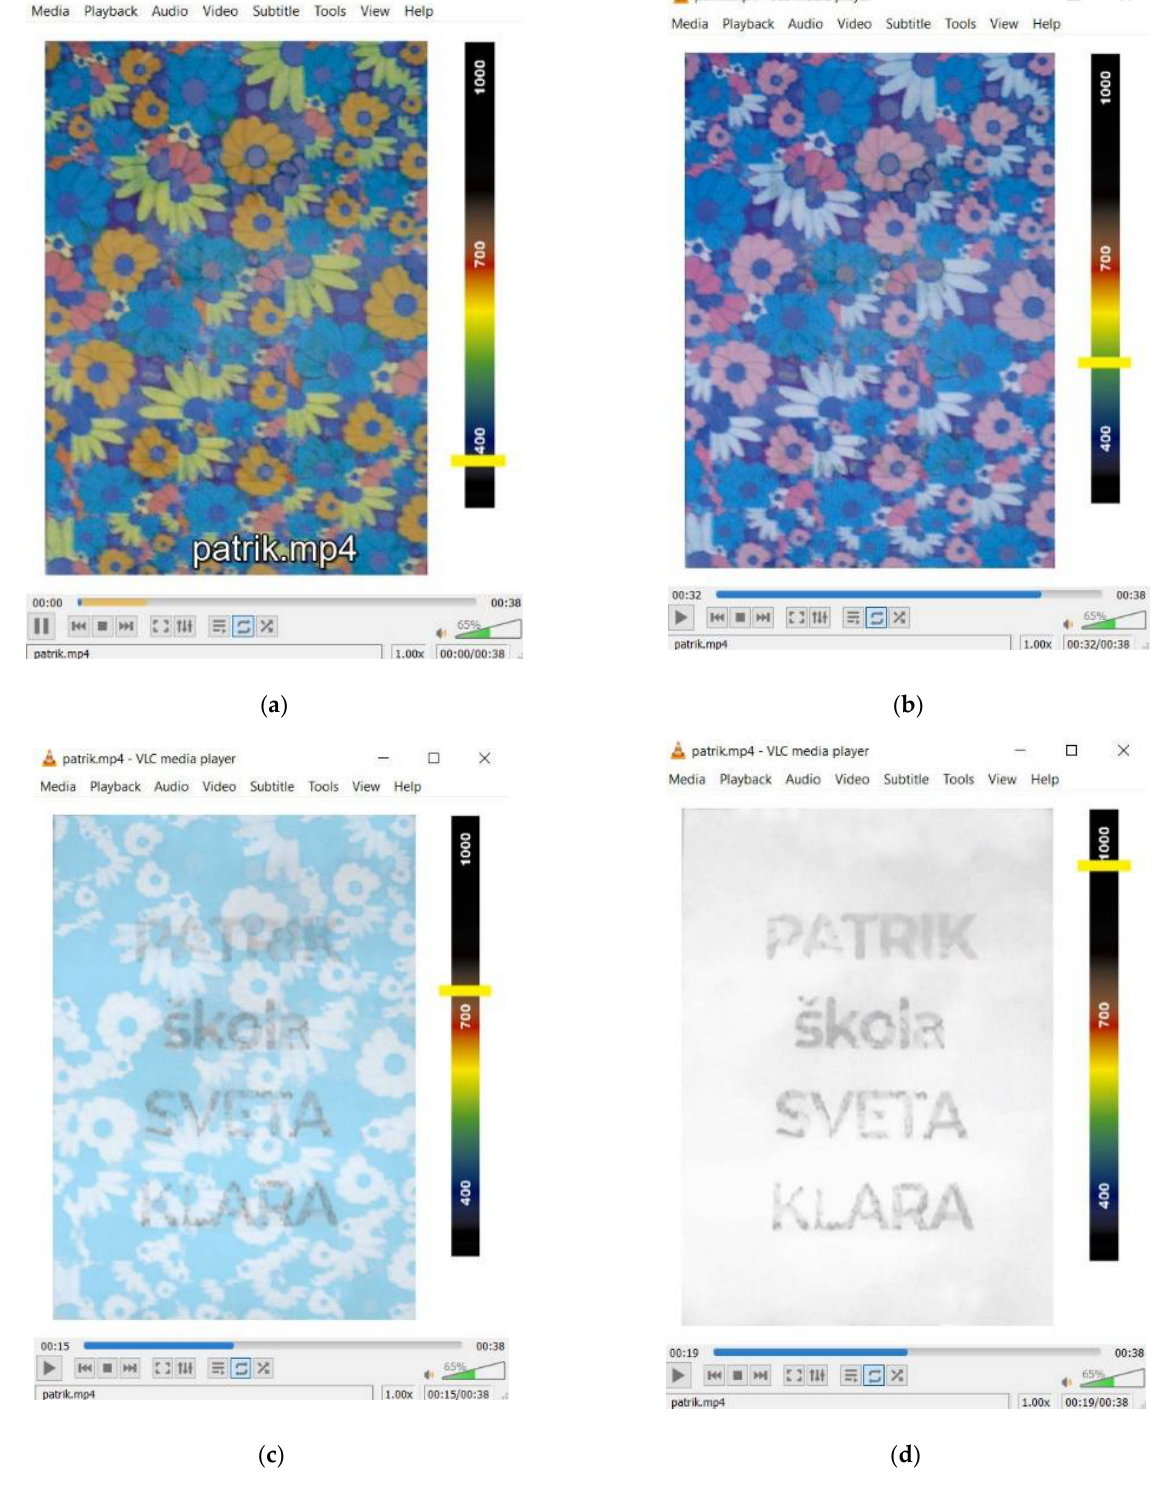
Figure 4. ( a ) Animation stop on 400 nm; ( b ) animation stop on 530 nm; ( c ) animation stop on 750 nm; ( d ) animation stop on 950